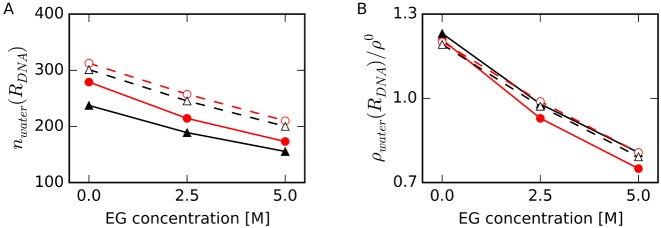
(A) Number of water molecules in the region RDNA, nwater(RDNA), and (B) relative number density of water molecules in the region RDNA to the density of bulk water, ρwater(RDNA) / ρ0, at different EG concentrations for HP (filled red circles with solid lines), TBA (filled black triangles with solid lines), unHP (open red circles with dashed lines) and unTBA (open black triangles with dashed lines). Standard errors of the mean (SEM), which were calculated with the average values for every 10 ns data from 50 ns to 100 ns MD simulations, are enough small within the sizes of symbols (also in Figures 5–9).